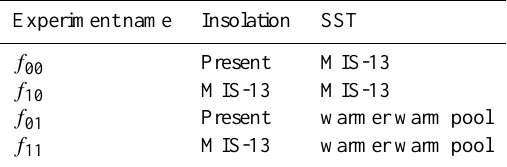
Table 1. Experiment list. “MIS-13” insolation means the insola- tion at 506ka BP. “MIS-13” SST means the simulated MIS-13 SST by Muri et al. (2013) using the atmosphere–ocean coupled model HadCM3 forced by the MIS-13 insolation and greenhouse gas con- centrations. “Warmer warm pool” SST is the same as “MIS-13” SST except that the SST over the IPWP is increased. Detailed infor- mation about forcing and boundary conditions is given in Sect.